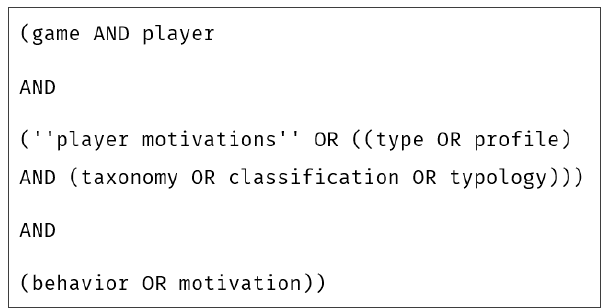
Figure 2. Search string submitted to the search